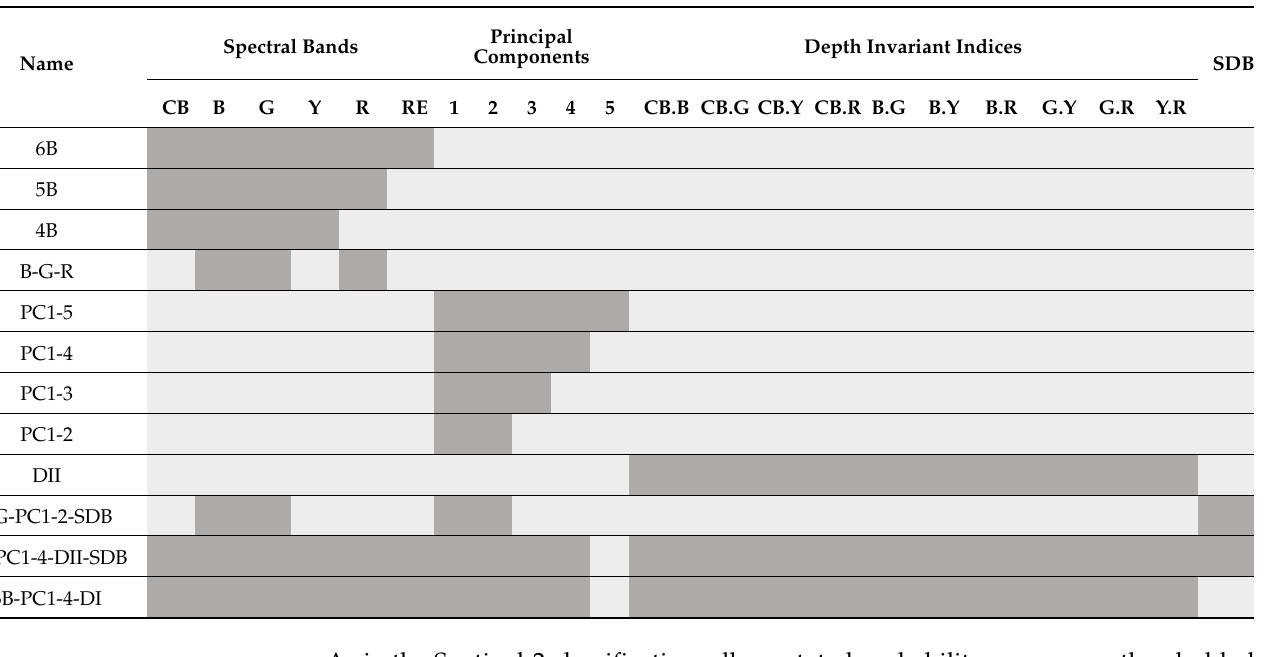
Table 2. Input data combinations explored in this study where dark grey shading indicates the param- eters included in the respective combinations and light grey shaded parameters were not included. Not all results are included in figures if classifications provided similar results. Name indicates how a classification is referenced in the following figures. Data combinations explored included spectral bands, principal components, depth invariant indices and satellite derived bathymetry